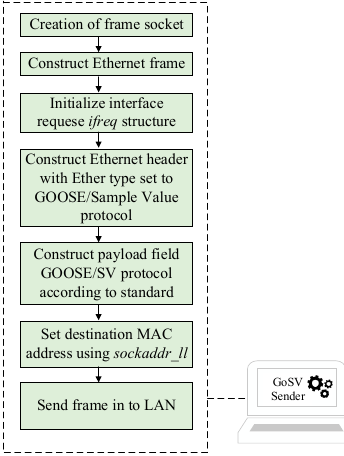
Figure 5. Frame generation process. Table 1. GOOSE payload fields.